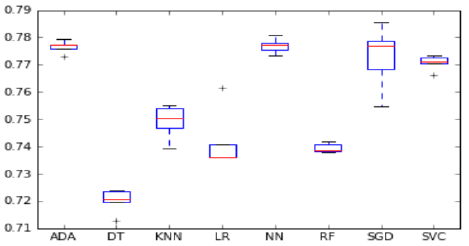
Figure 1. Algorithm accuracy comparison.